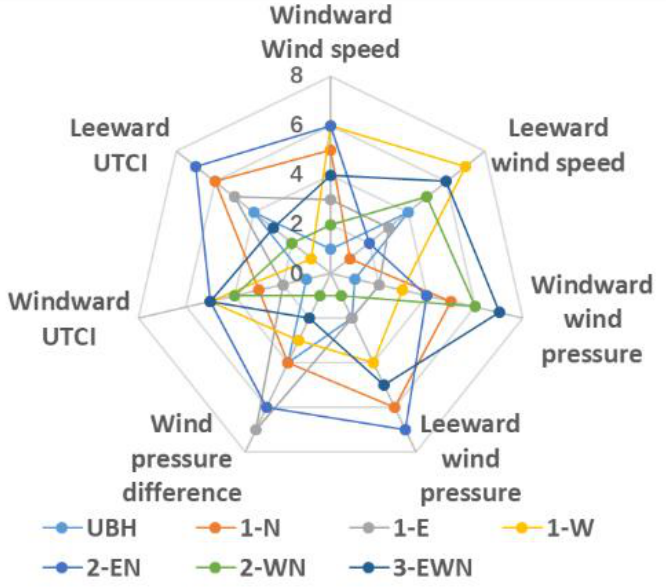
Figure 12. Wind environment and UTCI parameter ranking under seven distribution modes.